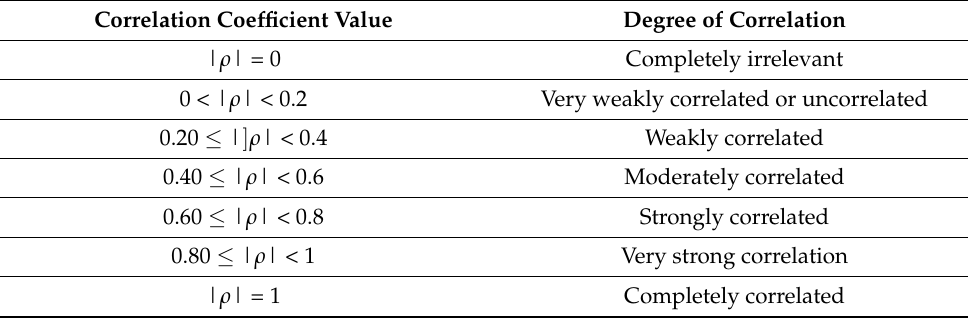
Table 1. Pearson correlation degree grading scale.